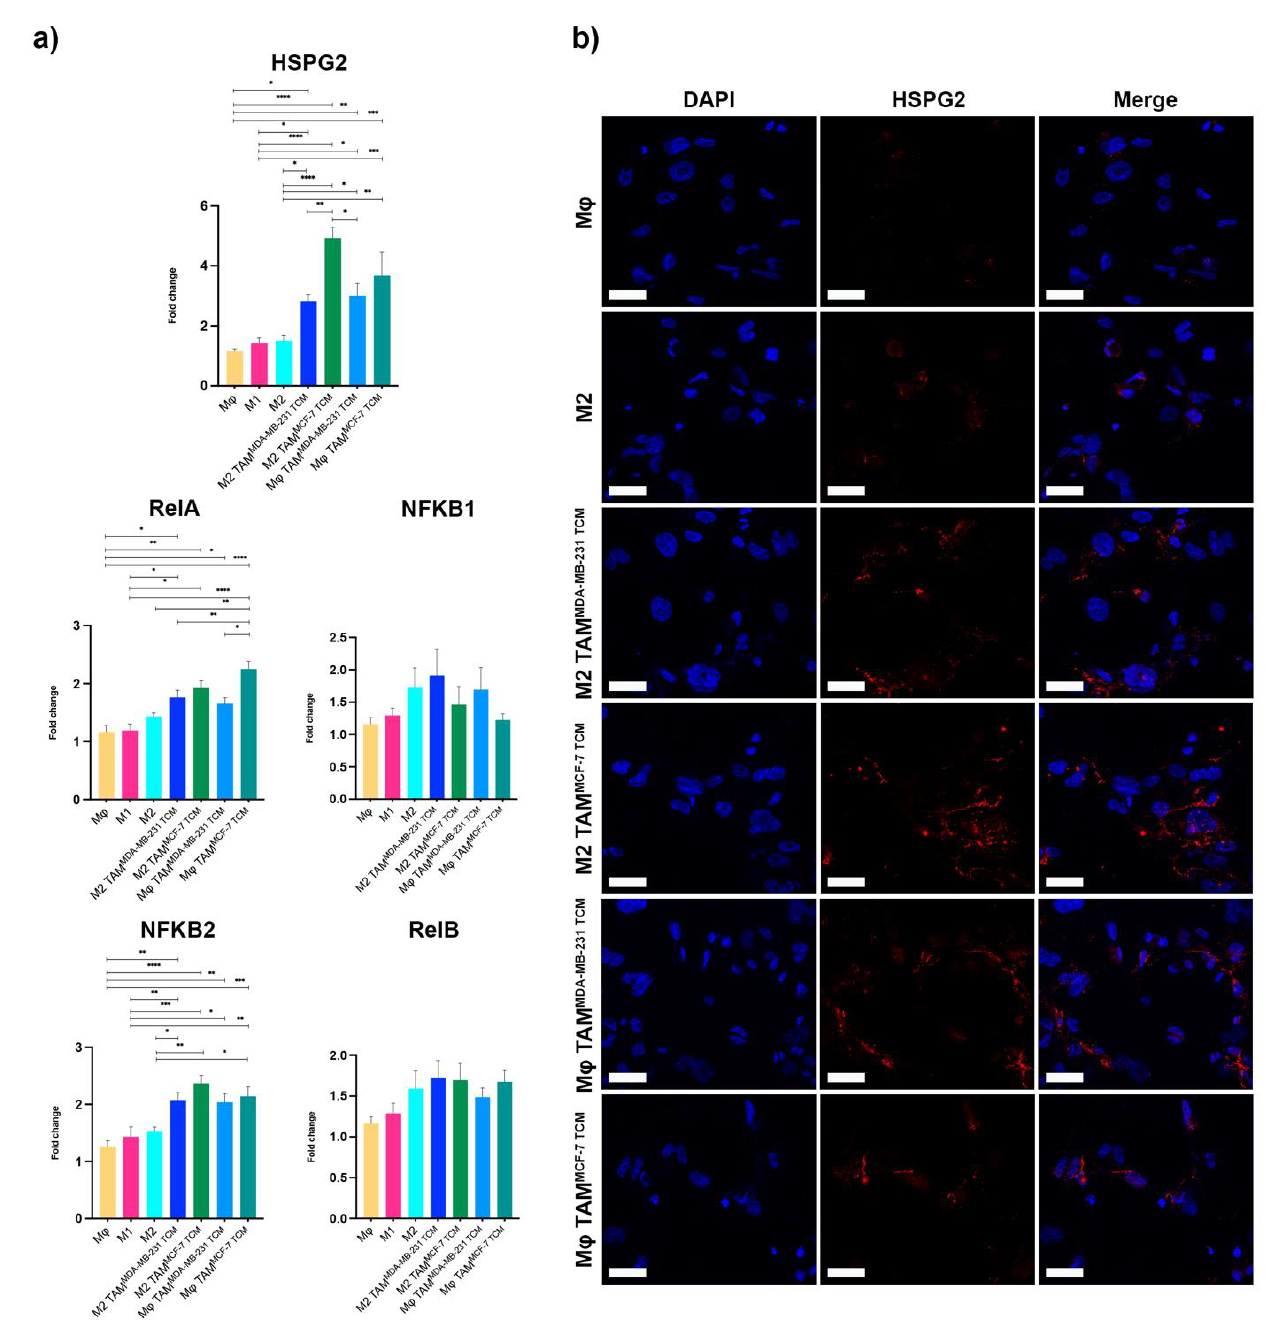
Figure 3. HSPG2 expression in macrophages. ( a ) Gene expression analysis of HSPG2 and canonical and non-canonical NF- κ B pathways were evaluated in untreated and treated macrophages by qRT- PCR. Error bars represent ± SEM. One-way ANOVA and Tukey correction were used to evaluate the differences between means; * p < 0.033, ** p < 0.002, *** p < 0.0002, **** p < 0.0001. n = 4 for each experimental group. ( b ) Immunofluorescence analysis of HSPG2 in untreated and treated macrophages showing HSPG2 in red and nuclei counterstained with DAPI. Scale bars represent 40 µ